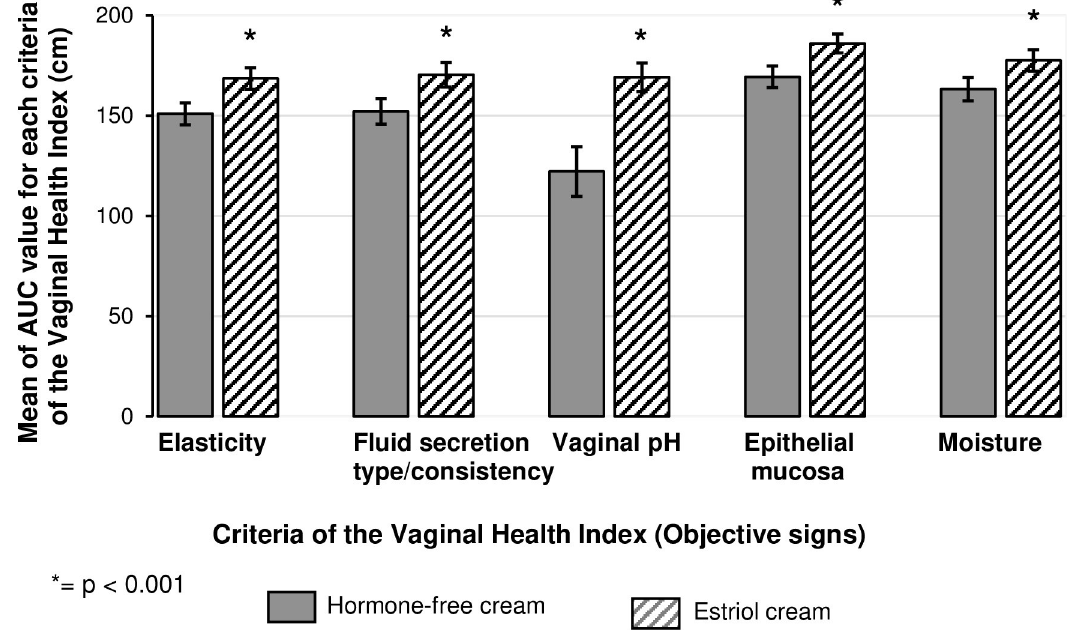
Fig 8. Objective assessment of vaginal findings. Improvement of all Vaginal Health Index criteria (objective assessment of vaginal findings) and significant differences in favor of the estriol cream. Number of patients (PP): Hormone-free moisturizing cream n = 74; Estriol cream n = 69. Mean AUC values ± 95% CI. Mann-Whitney-Wilcoxon tests were applied to evaluate any differences in the effect of the treatments (statistically significant, p <